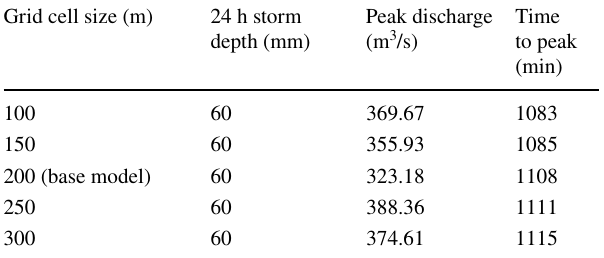
Table 11 Flood properties of calibrated GSSHA base model for a